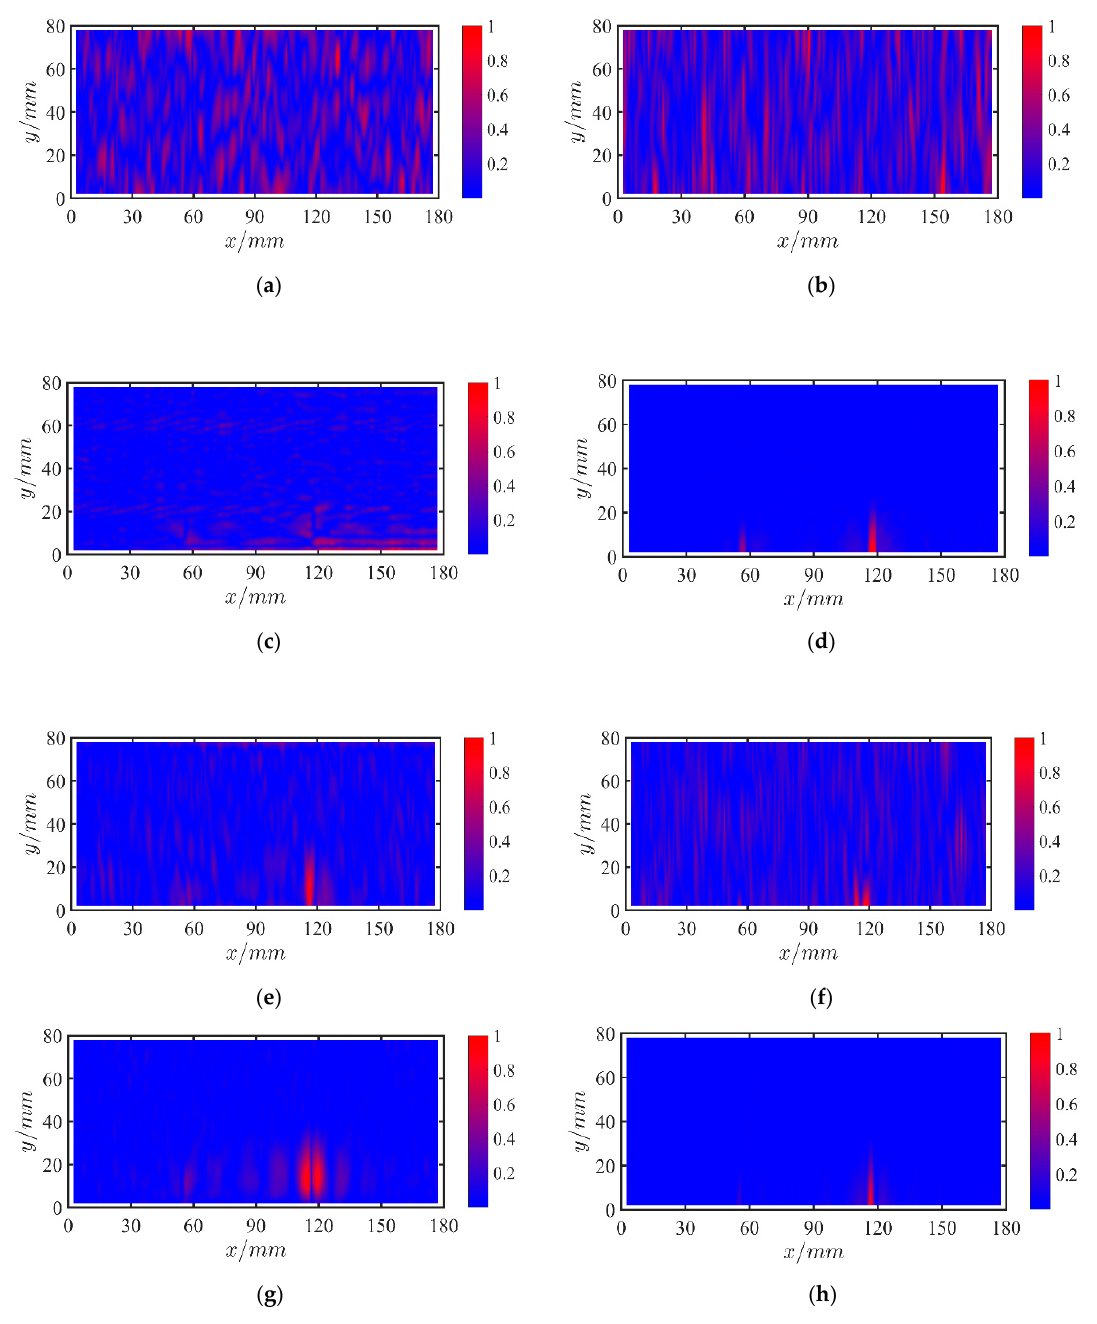
Figure 11. The RDIs colored plot of multi crack plate in the x and y directions. ( a ) RDIs of the first mode in the x direction. ( b ) RDIs of the first mode in the y direction. ( c ) RDIs of the second mode in the x direction. ( d ) RDIs of the second mode in the y direction. ( e ) RDIs of the third mode in the x direction. ( f ) RDIs of the third mode in the y direction. ( g ) RDIs of the fourth mode in the x direction. ( h ) RDIs of the fourth mode in the y direction.